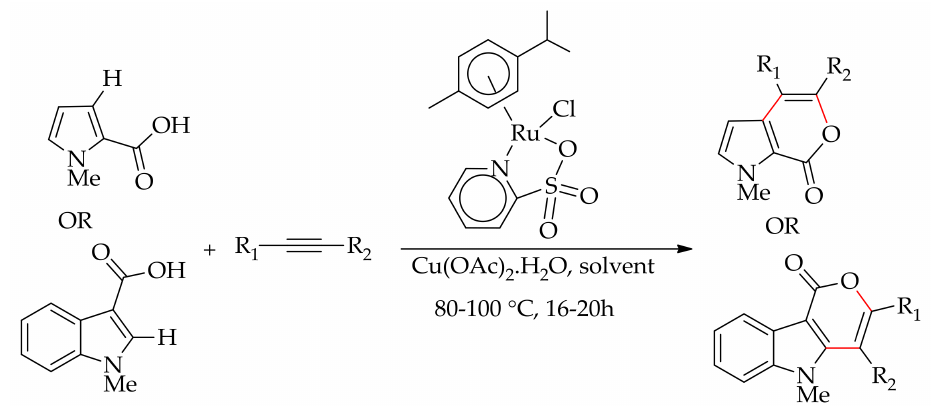
The ruthenium-catalysed regioselective cyclization of ketones and alkynes leading to indenols and benzofulvenes was described by Chinnagolla and Jeganmohan using [RuCl 2 ( p -cymene)] 2 in association with AgSbF 6 in the presence of Cu(OAc) 2 · H 2 O in DCE [173]. In the following year, they achieved ruthenium-catalysed cyclization of aromatic nitriles and alkynes employing [RuCl 2 ( p -cymene)] 2 in the presence of KPF 6 and Cu(OAc) 2. H 2 O in acetic acid under air (Scheme 87) [174].